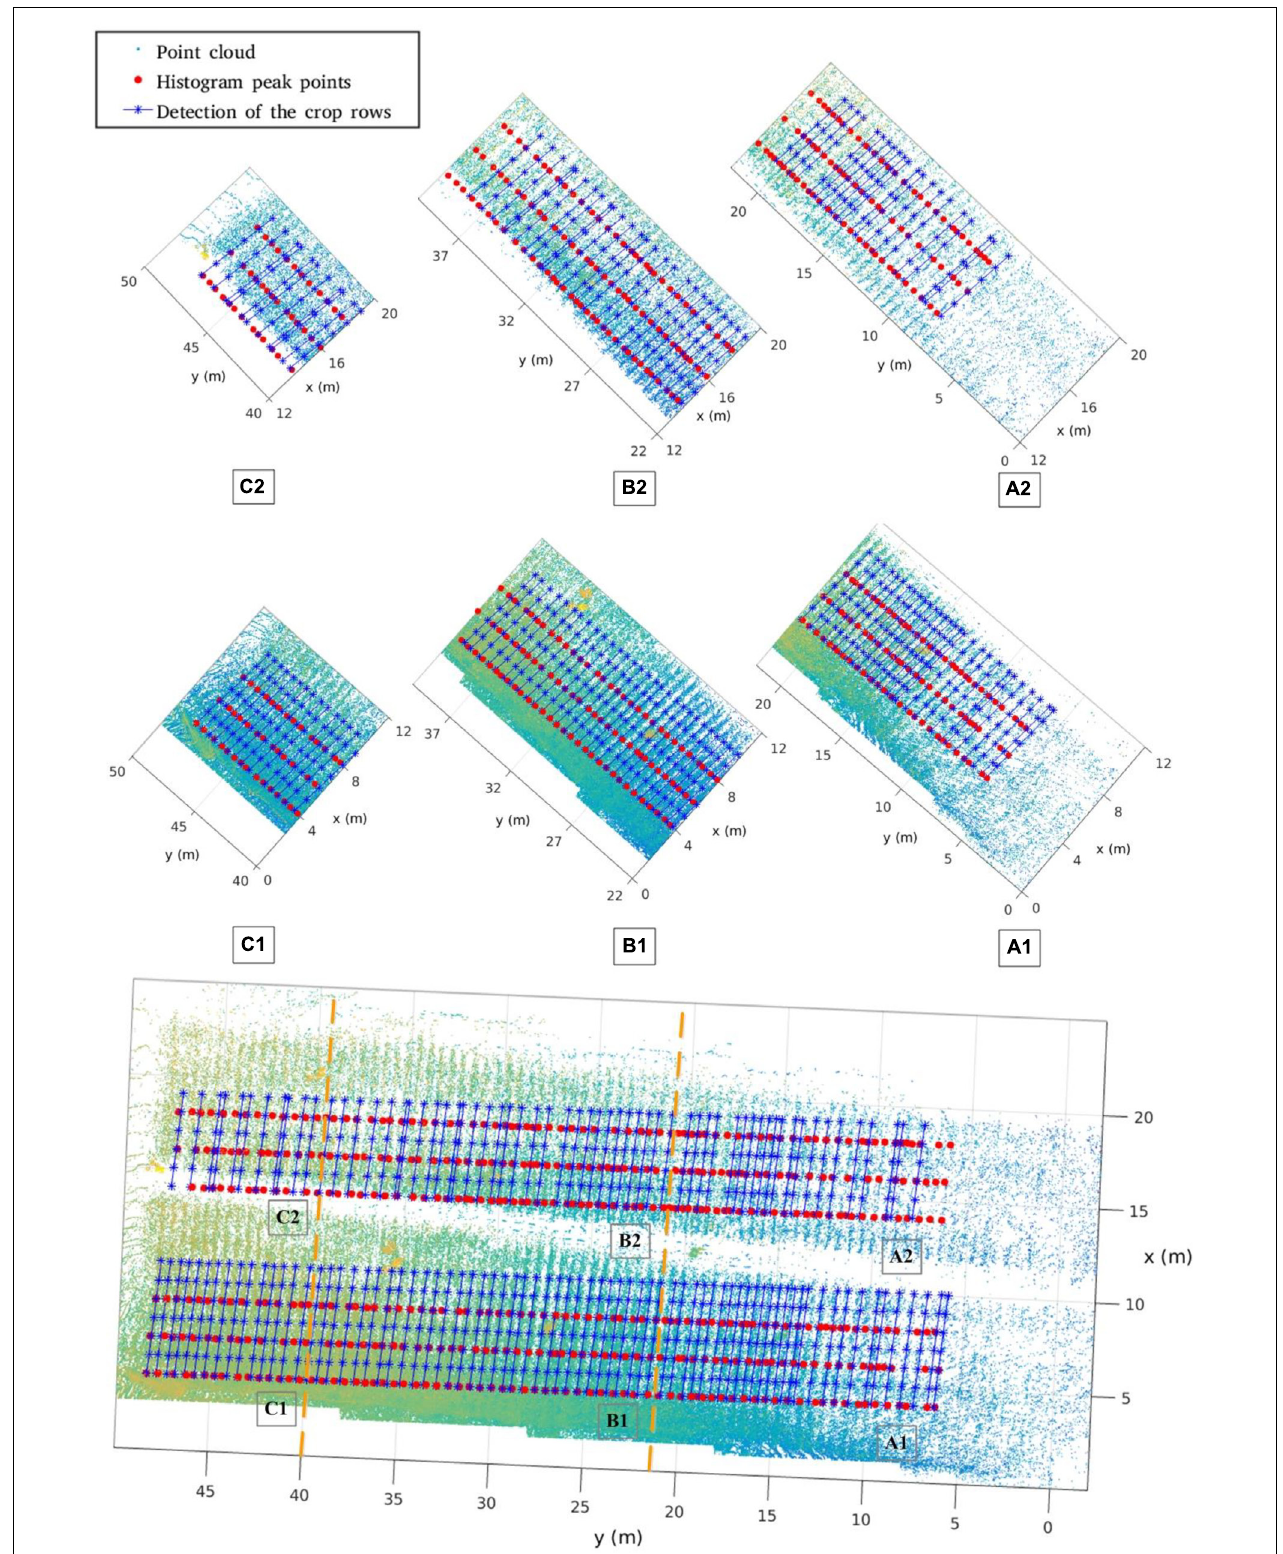
FIGURE 17 | Row detection result for